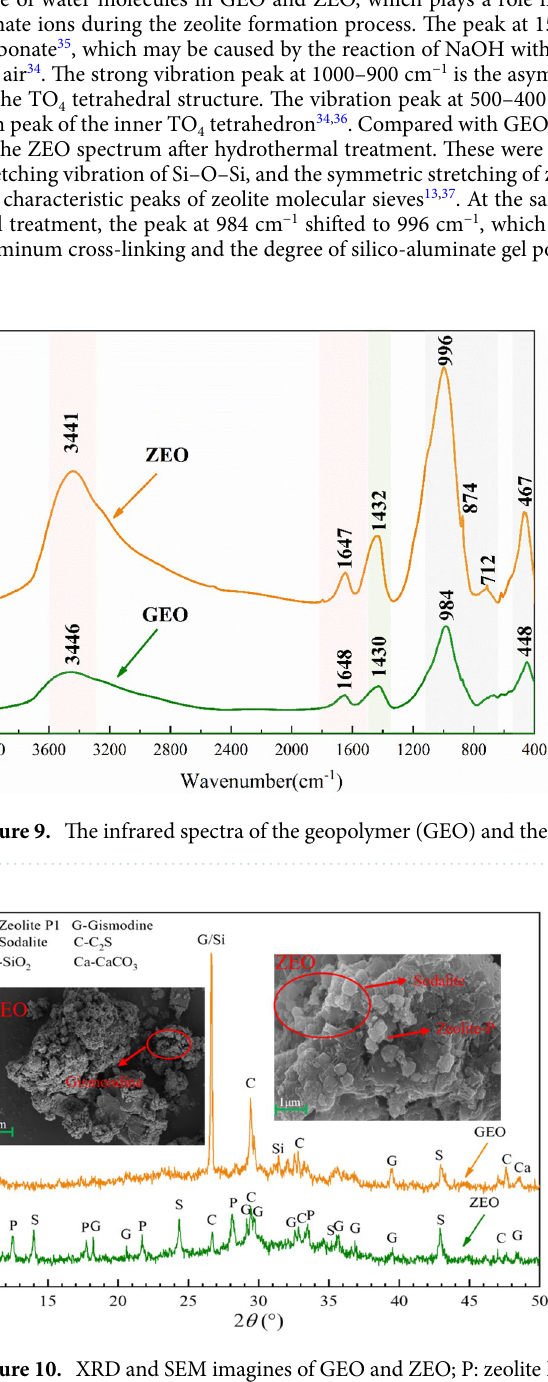
Figure 10. XRD and SEM imagines of GEO and ZEO; P: zeolite P1, G: gismodine, S: sodalite, C: C 2 S, Si: SiO 2 , Ca: